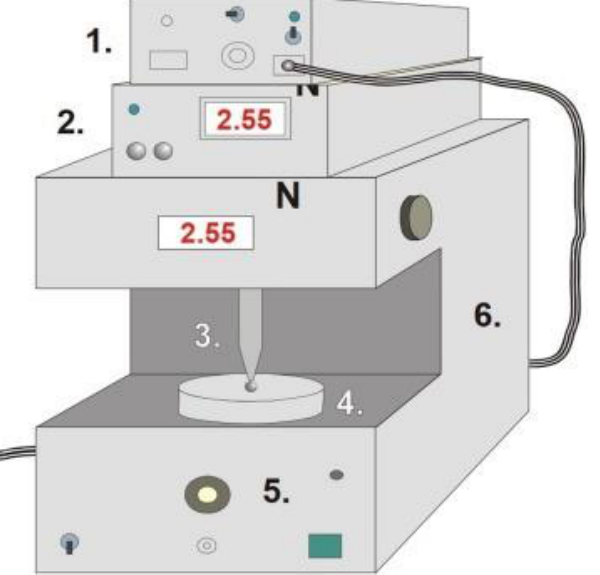
Figure 1. Schematic diagram of the tensile strength and mucoadhesion texture analyzer ( 1 —interface, 2 —force display, 3 —rod-like or needle-like probe (jowl), 4 —sample holder, 5 —force measurement unit, and 6 —motor).